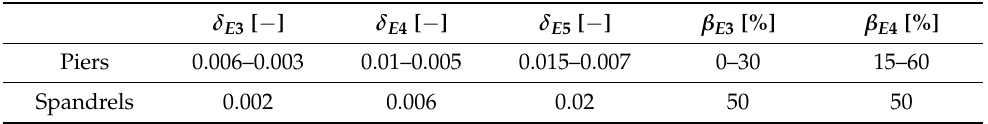
Figure 8. Piecewise-linear constitutive law and hysteretic response of the model. Table 3. Thresholds used for piers and spandrels. For piers, the first and second values were assumed for a prevailing flexural behaviour and shear behaviour,